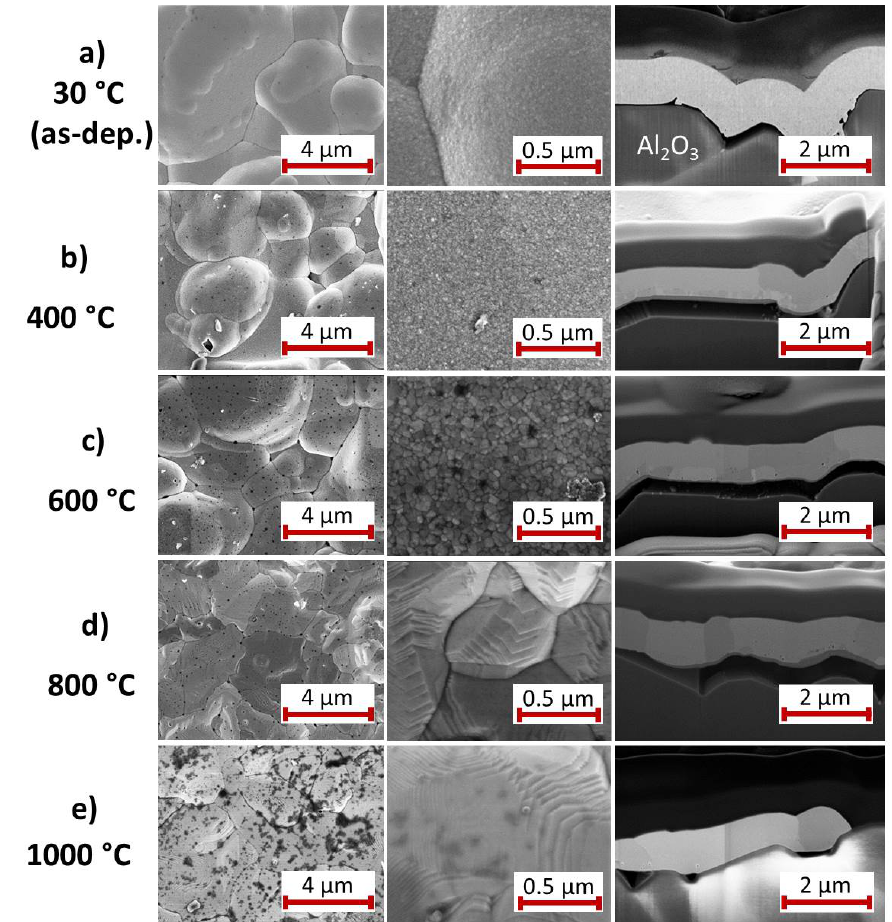
Figure 12. SEM images (InLens, 5 kV, 3 mm working distance) with two different magnifications of the surface of the Pt ∗ film on Pt seed layer ( a ) after deposition and after annealing for 2 h in air at ( b ) 400; ( c ) 600; ( d ) 800 and ( e ) 1000 ◦ C. On the right hand side an SEM image (InLens, 3 kV, 5 mm working distance) of the film cross-section is